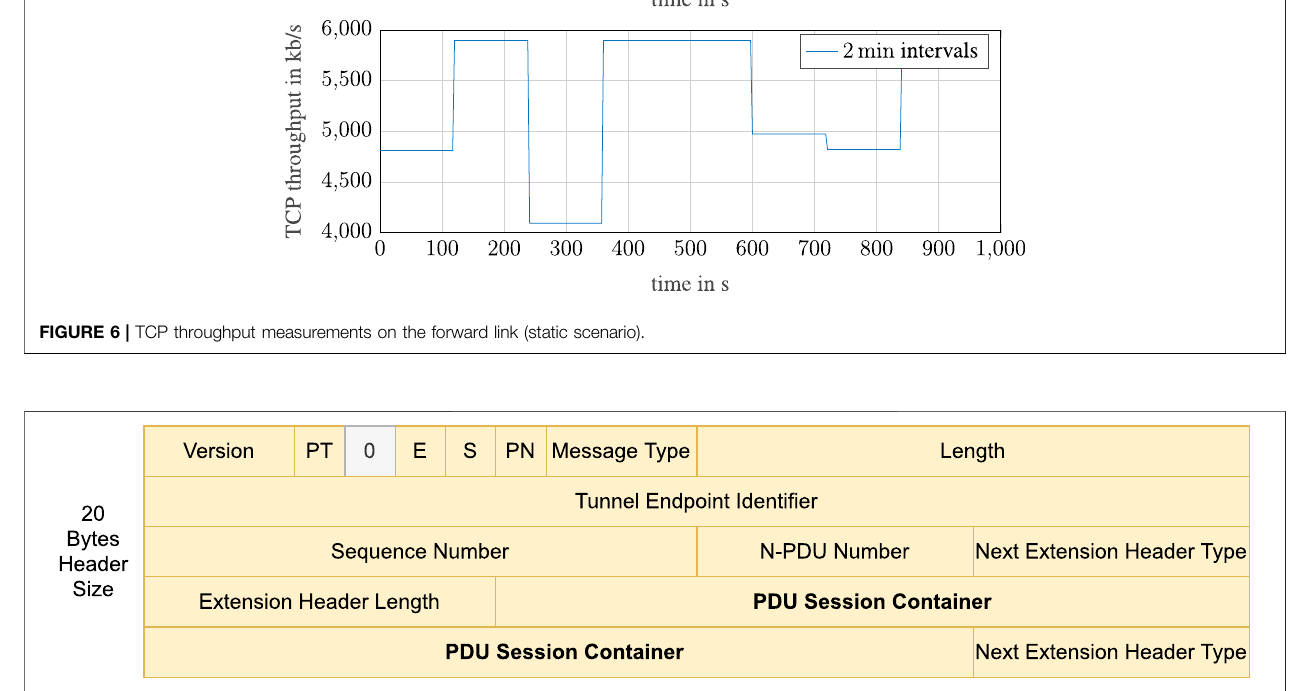
FIGURE 7 | GTP-U header, Johnson